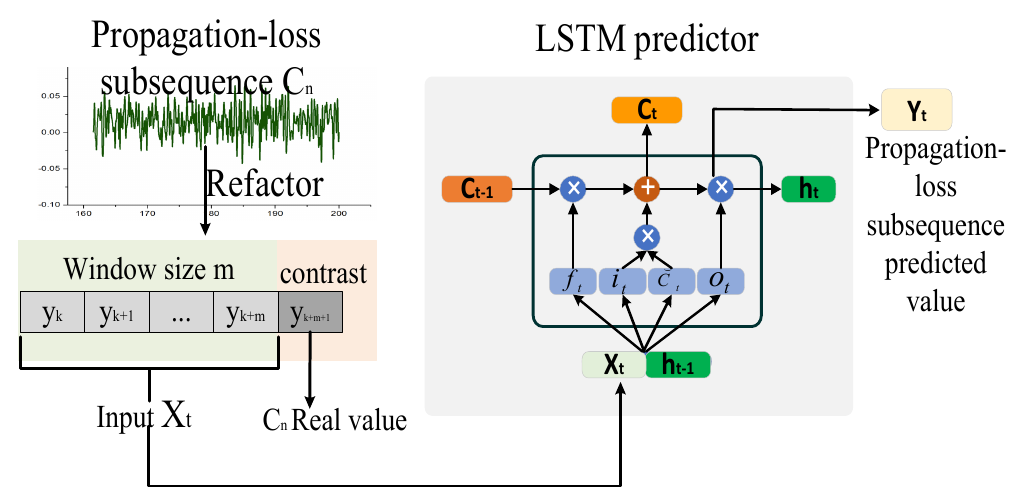
Figure 4. Propagation-loss subsequence predictor based on long short-term memory (LSTM).